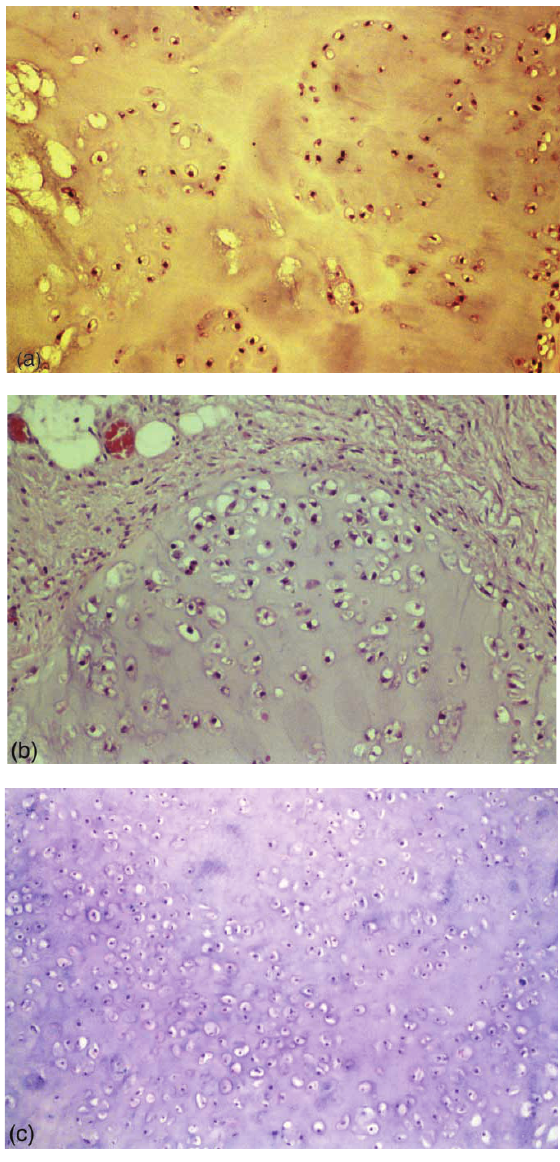
Fig. 2. Sequential photomicrographs of lesions from our case, suggesting progression from synovial chondromatosis to chondrosarcoma. (a) Right hip cartilaginous clusters from 1992, showing clustering of hypocellular chondrocytes within connective tissue. The nuclei are slightly enlarged and hyperchromatic, with no significant pleomorphism. (b) Right hip cartilaginous clusters from 1994, showing a slight increase in cellularity with a relative loss of clustering architecture. There is no significant nuclear atypia. (c) Right hemipelvectomy specimen from 1999, showing (although focally) chondrocytes arranged in sheets, cellular crowding, and a focally myxoid matix, but without significant nuclear atypia.